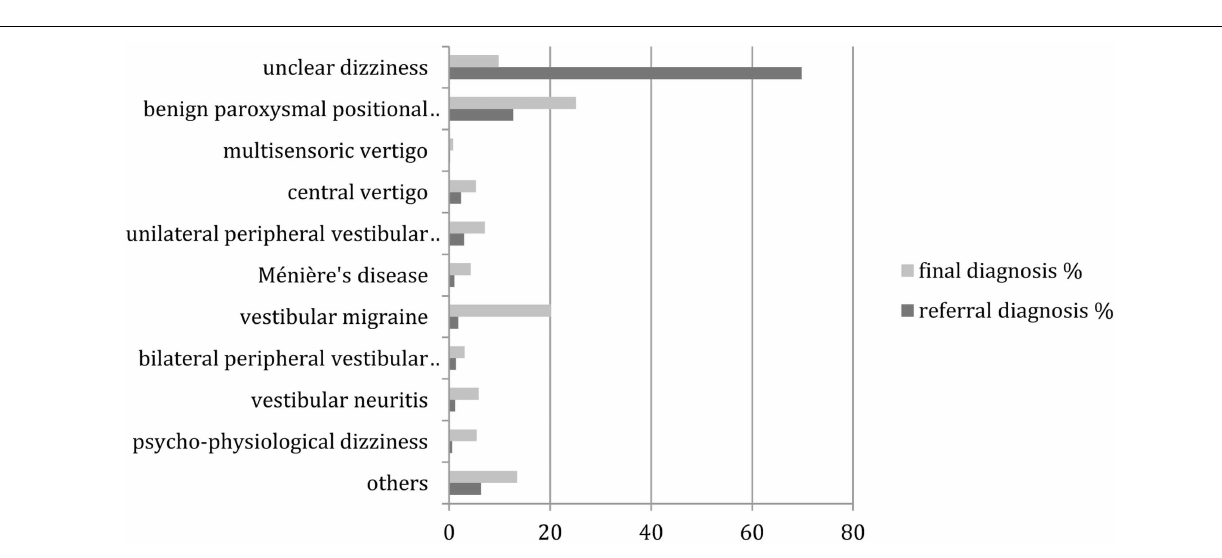
vestibular paroxysmia, acoustic neuroma, canal dehiscence syndrome, mal de débarquement, ototoxicity, dizziness after cervical spine distorsion, vertigo in cervical pain